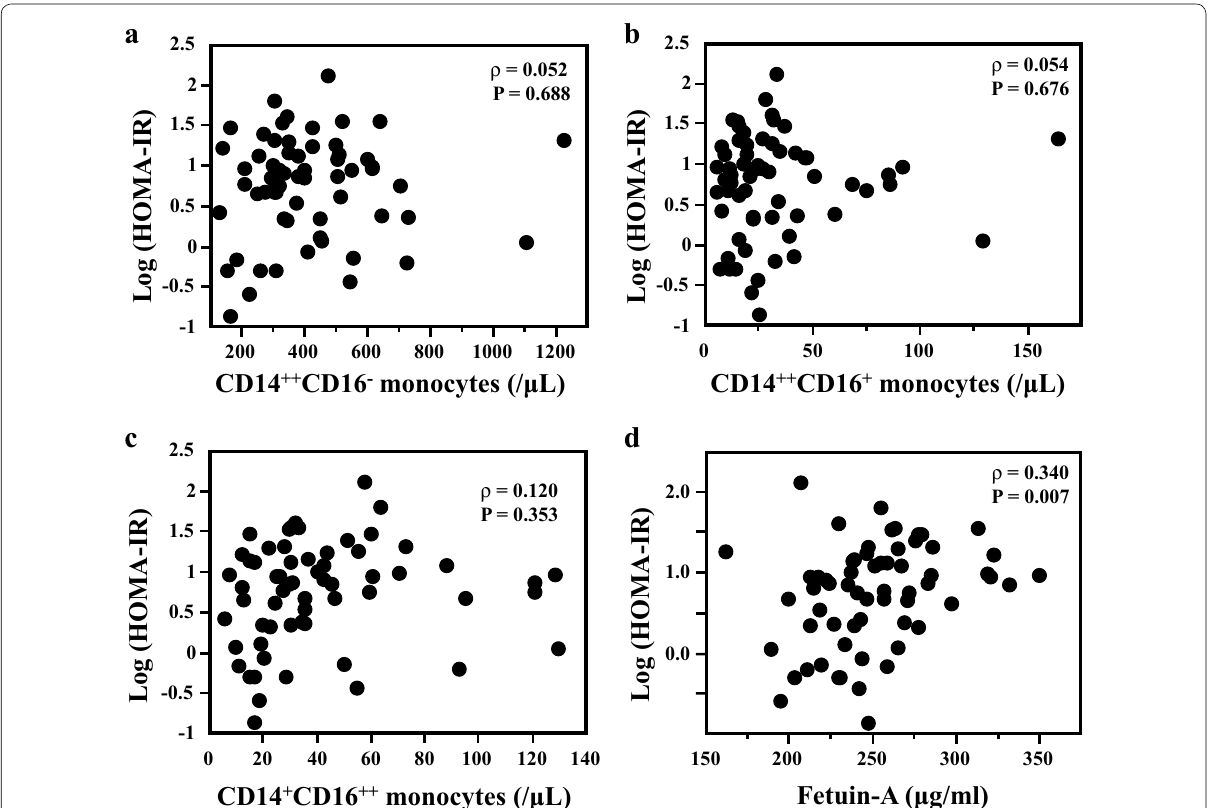
Fig. 2 The association of log (HOMA-IR) with monocyte subsets ( a – c ) and serum levels of fetuin-A ( d )